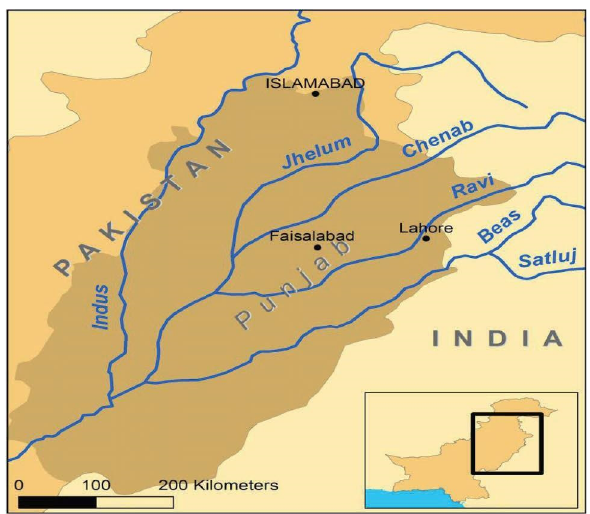
Figure 2: Chenab river basin and its adjoining river map. Table 2: Linear correlation analysis among